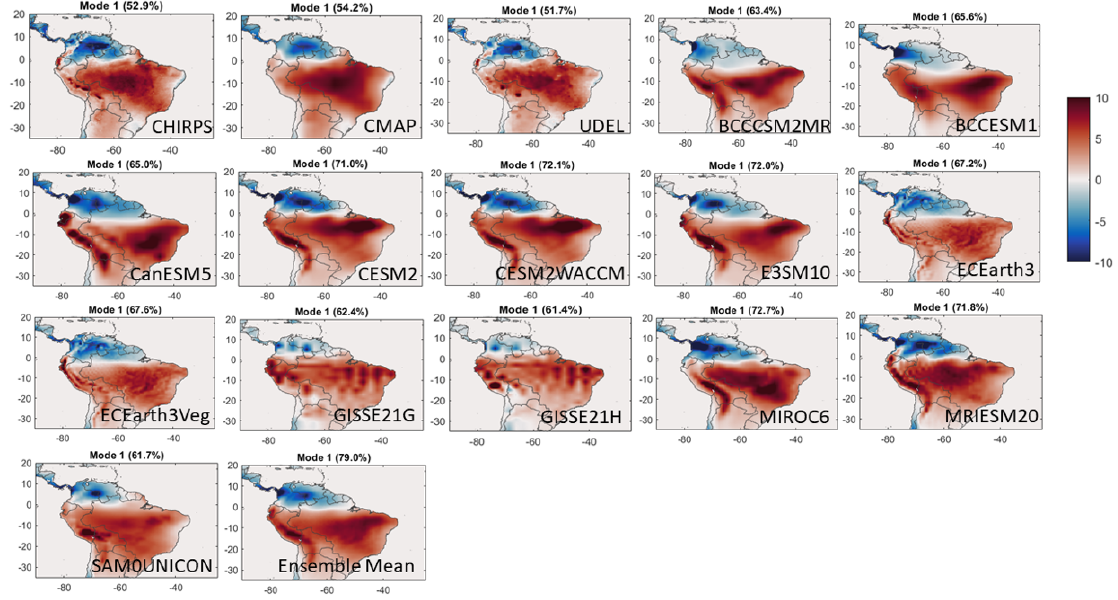
Figure 8. EOF eigenvector one for each dataset (1981–2014) with long-term mean removed.